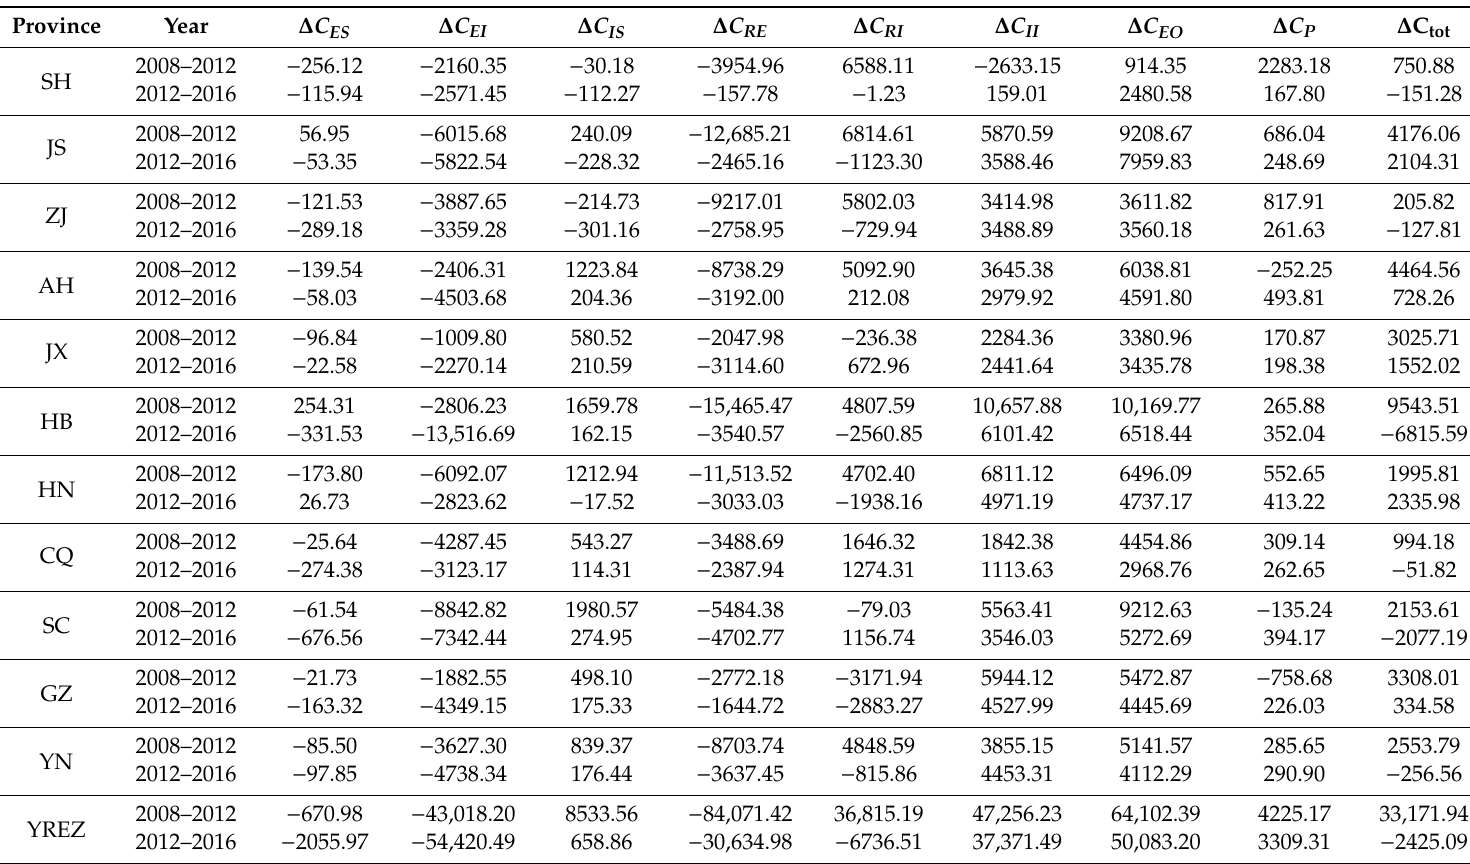
Table 2. The cumulative e ff ect of influencing factors a ff ecting IECEs in the sub-regions and the YREZ during 2008–2016 (unit: 10 4